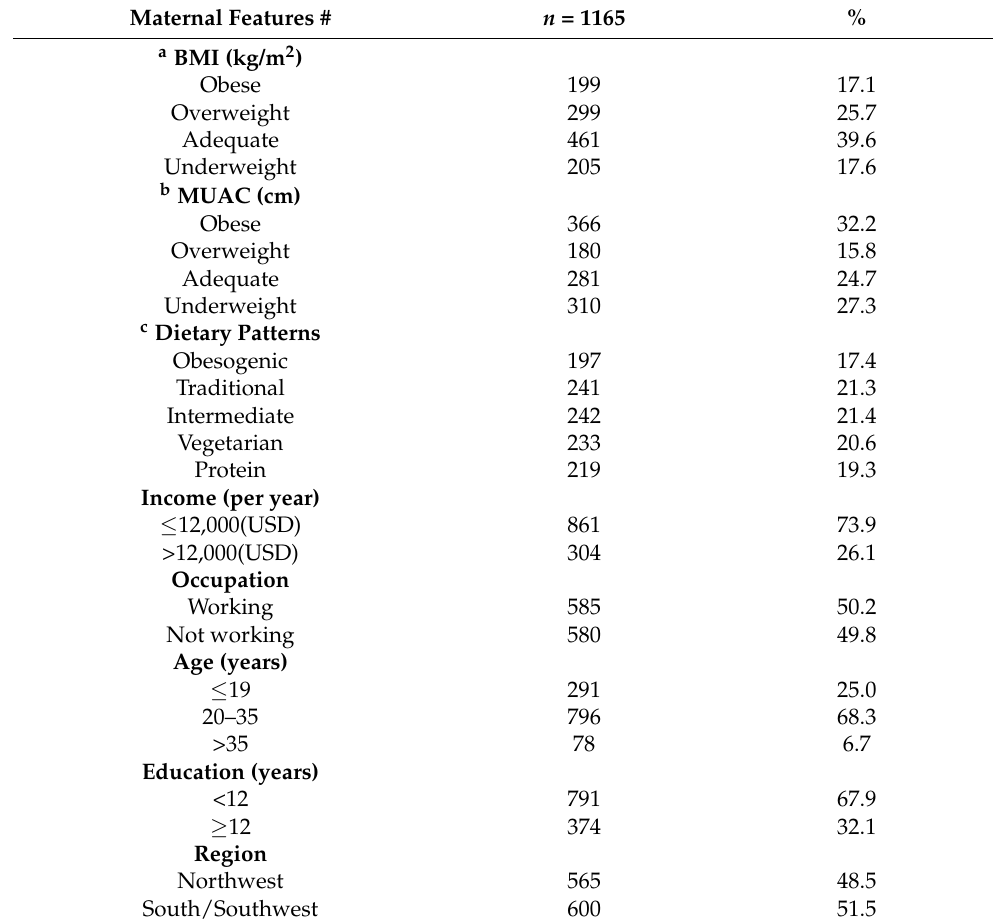
Table 1. Sample characterization according to sociodemographic and nutritional characteristics of pregnant